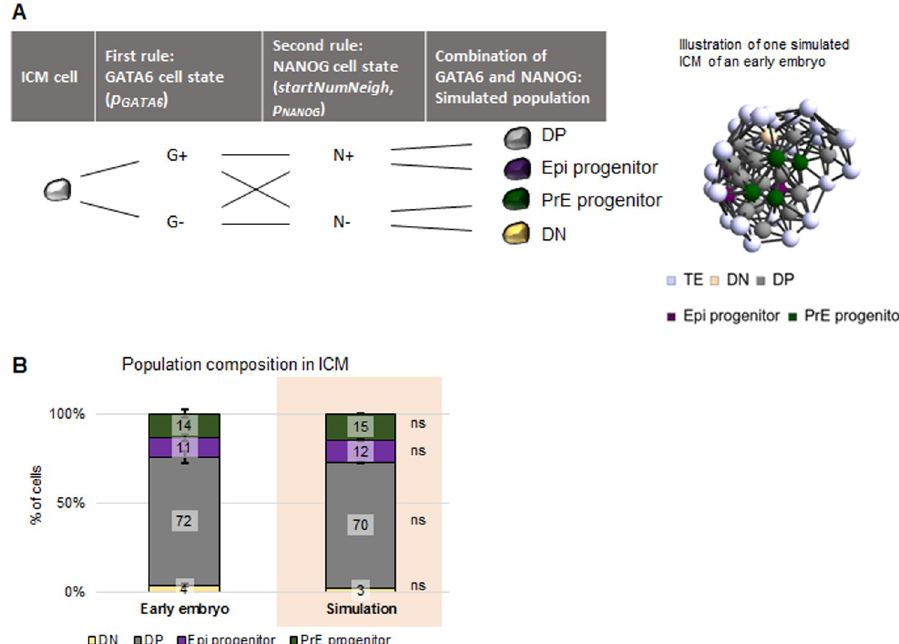
Fig 6. Simulation of two rules recapitulates population composition in early blastocysts. (A) Diagram depicting the population type assignment to the cells in the simulations (left) and an example of a simulated three-dimensional cell distribution (right). See main text and S1 Text for further details on the two rules and parameters. (B) Proportion of DN, DP, Epi progenitor and PrE progenitor ICM cells in early blastocysts in data II (first bar) and upon simulating the model (pink background) presented in (A). For the parameters used, see the main text and S1 Text. z-test; � : p < 0.05. The error bars indicate the standard errors of the means.